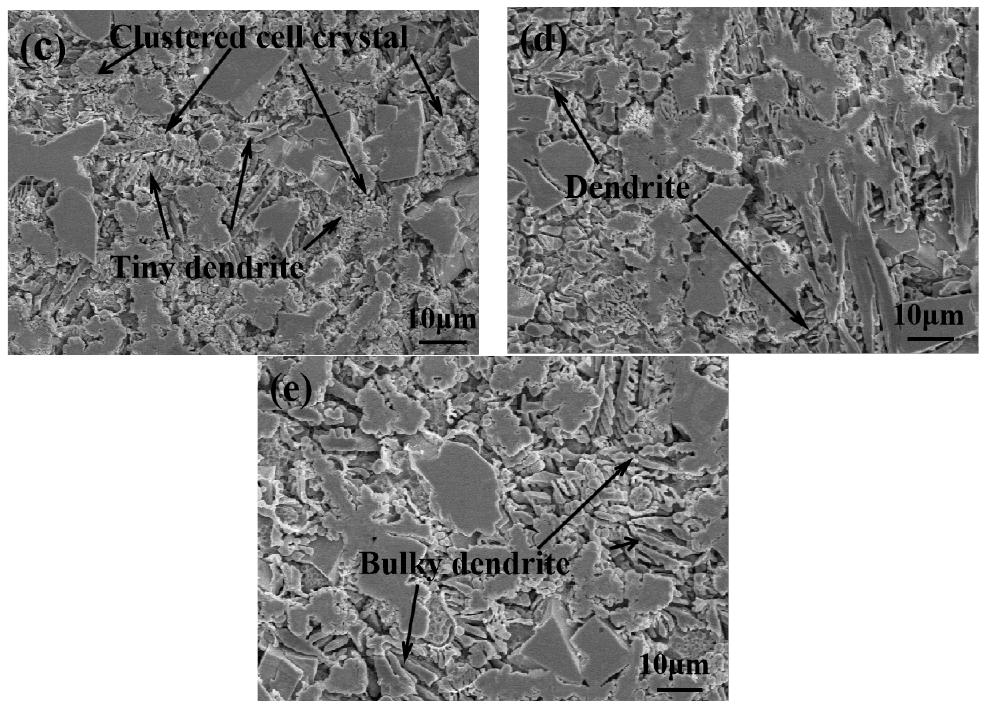
Figure 5. SEM images of the CeO 2 -modified coatings: ( a ) 0.0%, ( b ) 0.5%, ( c ) 1.0%, ( d ) 1.5%, and ( e ) 2.0%.